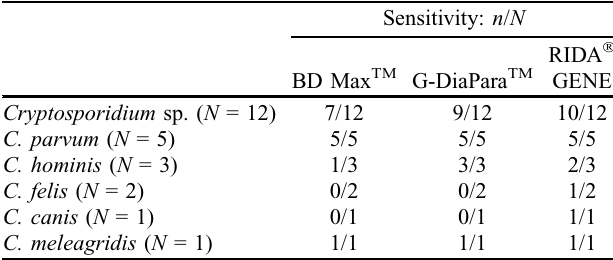
Table 3. Results for the Cryptosporidium sp. panel from the